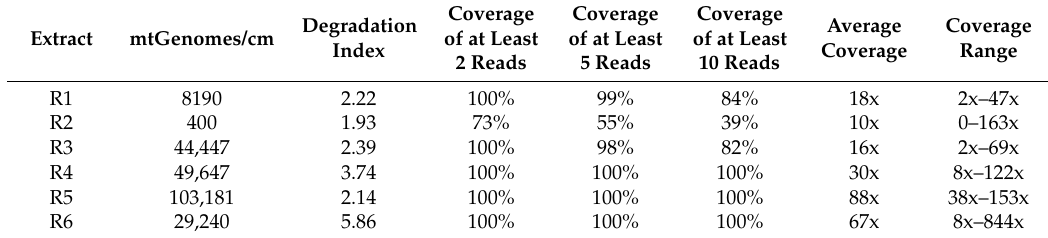
Table 6. mtDNA quantitation values, degradation indexes, and coverage over the mtGenome for six single recent hairs.